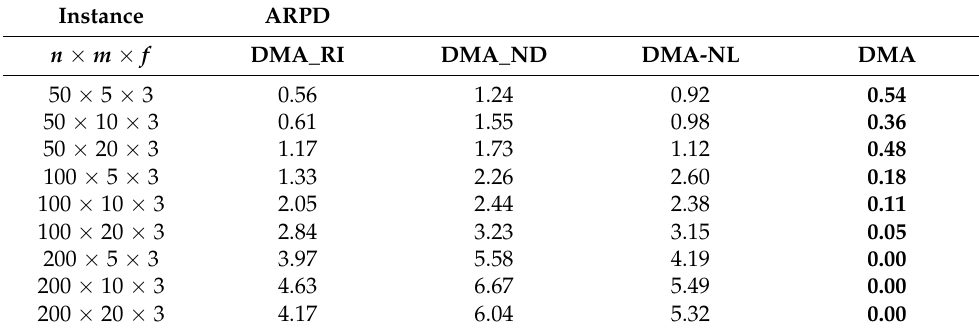
Table 2. Comparison results between DMA and its variant